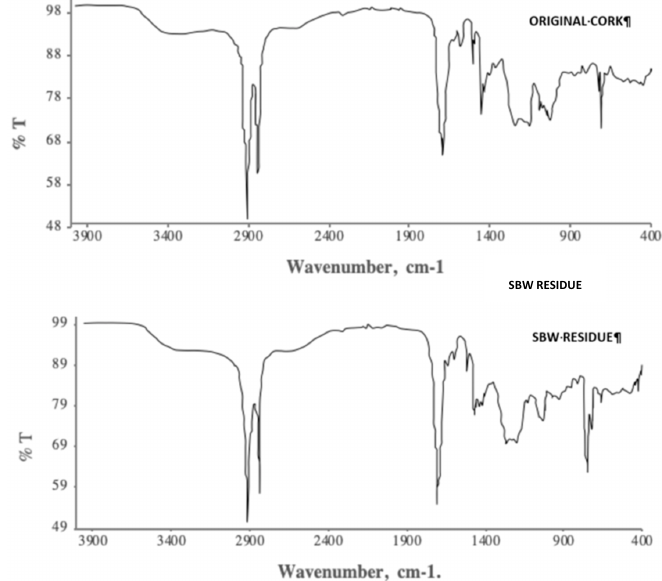
Figure 1. FTIR spectrum of the isolated suberin monomers from granulated cork, before and after the SBW treatment.